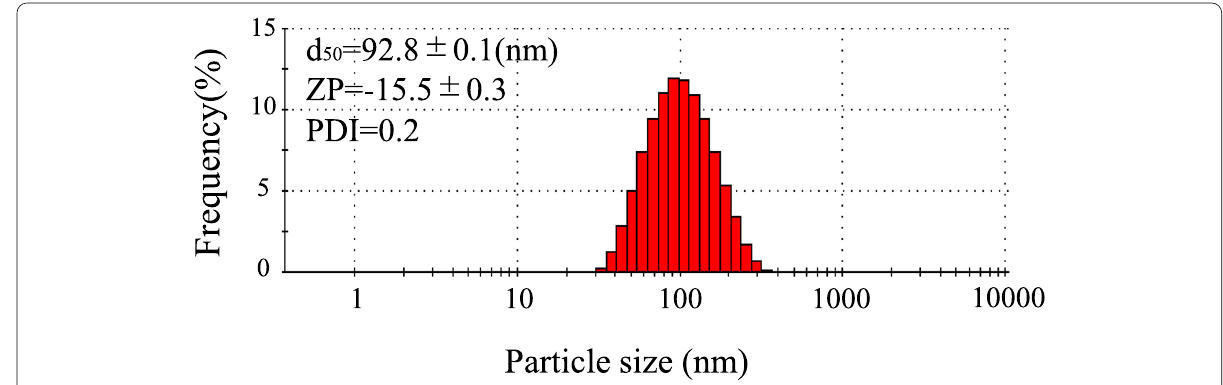
Fig. 2 Particle size and zeta potential of nanoparticles of Sol/ASC-DP/NOB